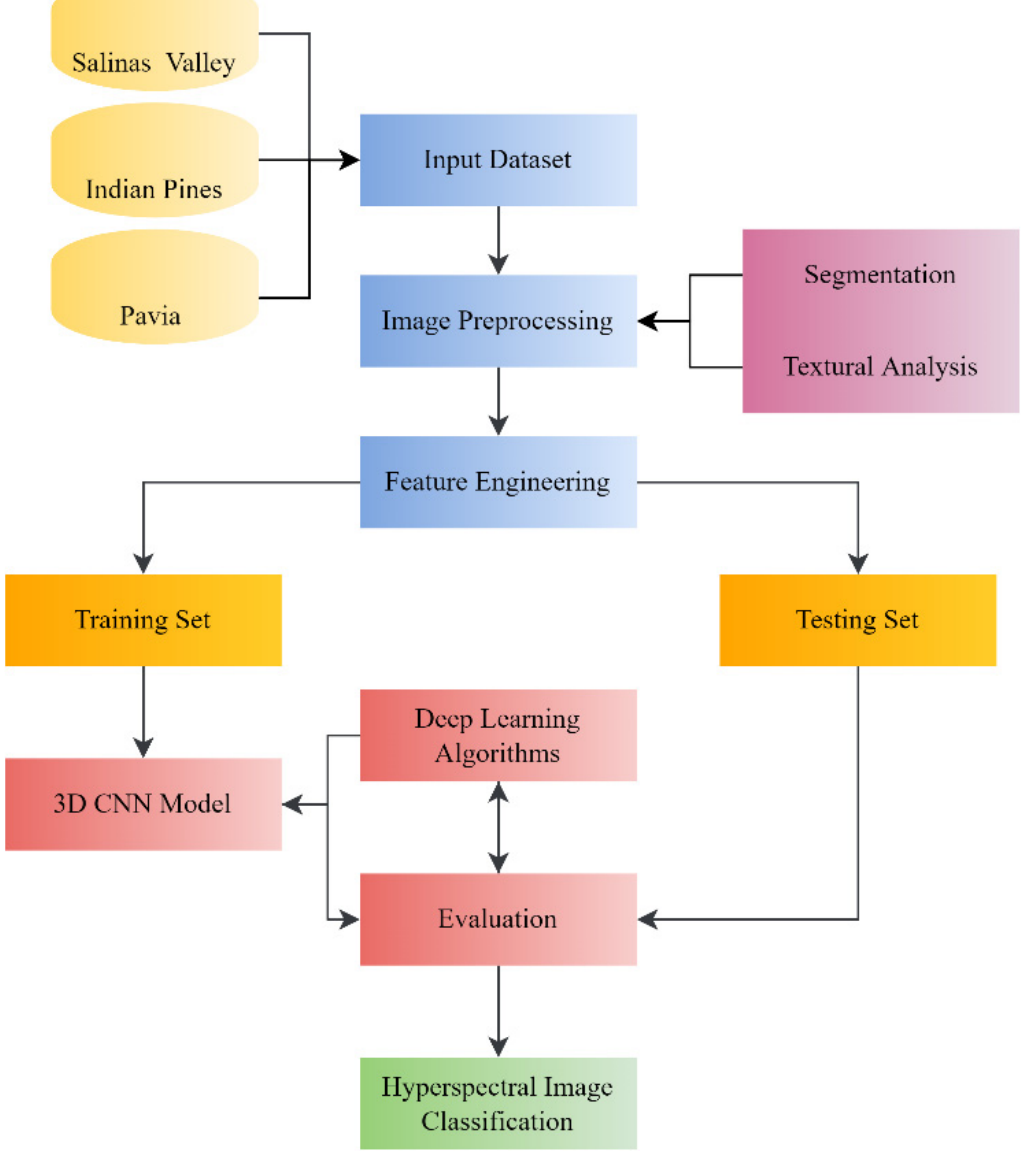
Figure 1. Proposed Workflow.